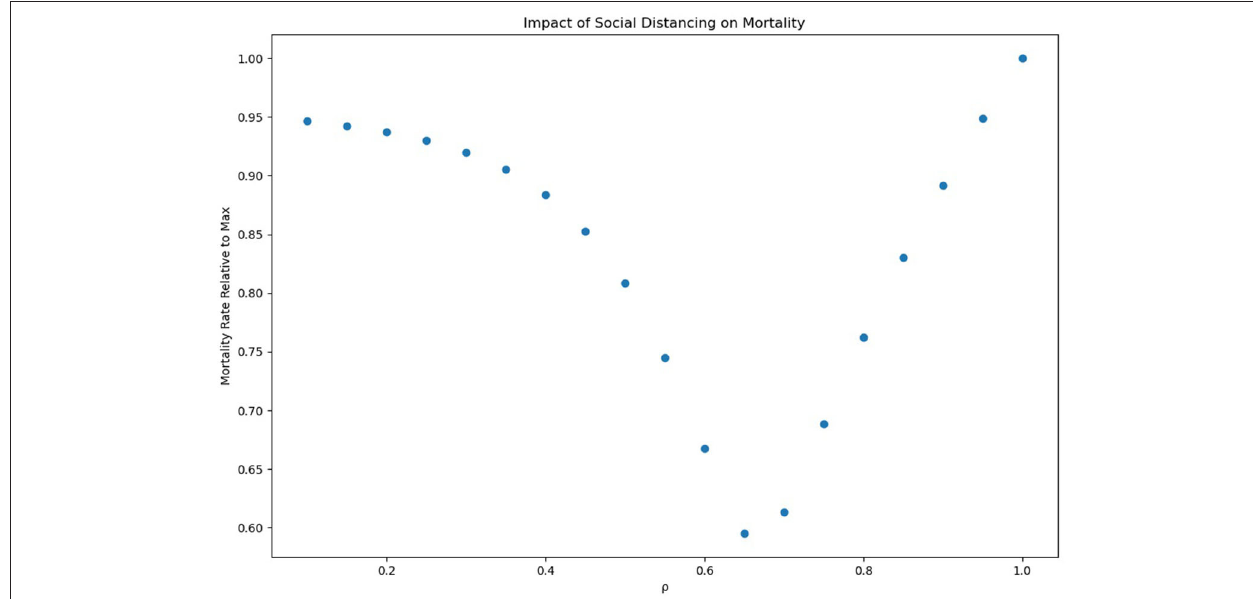
FIGURE 1 | Mortality relative to base mortality.